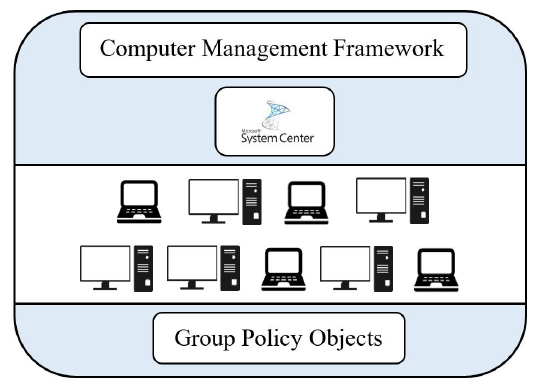
Fig 1. Frameworks to manage PCs at